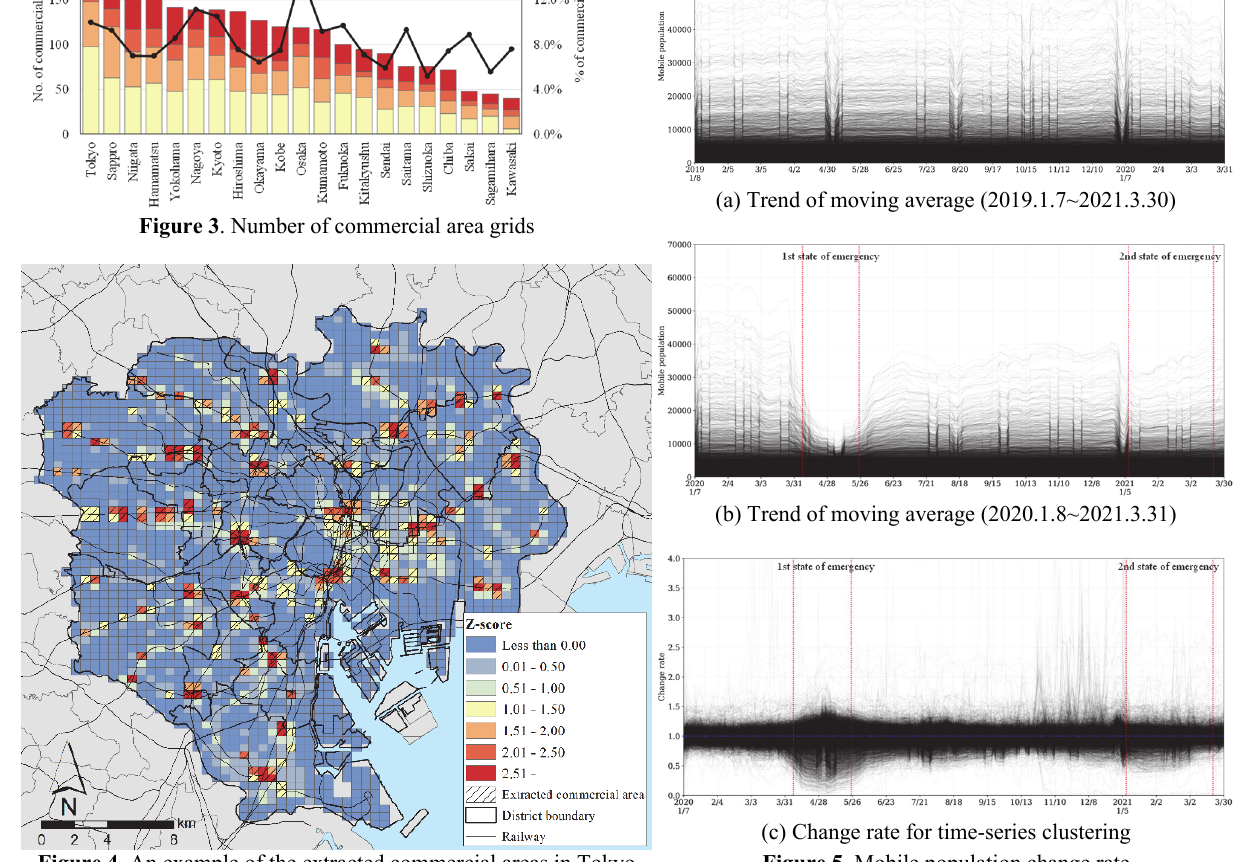
Figure 4 . An example of the extracted commercial areas in Tokyo Figure 5 . Mobile population change